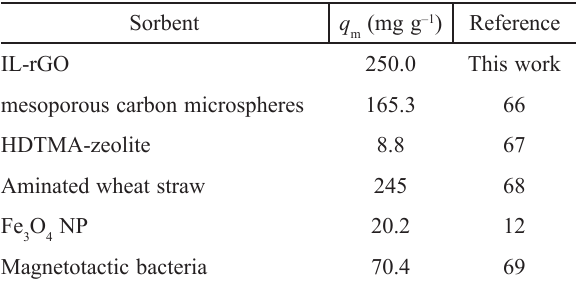
Table 4 – The q values for the sorption of chromate on dif- m ferent sorbents